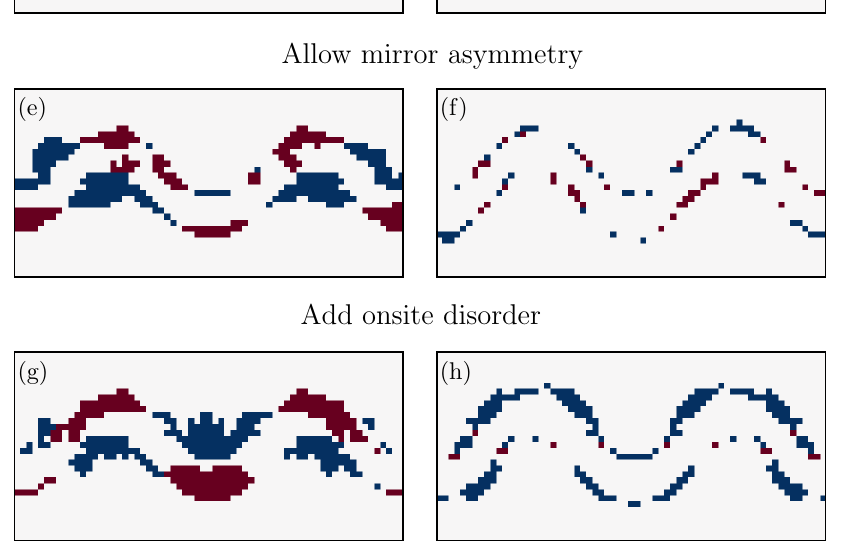
Figure 6: Comparison of optimized geometries with a reference geometry obtained by optimizing a straight junction with homogeneous chemical potential. In the pan- els we plot the difference of the magnitude of the superconducting gap of the ref- erence geometries and the optimized geometries. The left panels show the geome- try obtained after 50 epochs, and the right panels after convergence. Panels (a-b) correspond to geometries obtained with a different random seed, (c-d) starting the optimization from a zigzag shape, (e-f) allowing the optimizer to choose mirror- asymmetric perturbations, and (g-h) in the presence of onsite